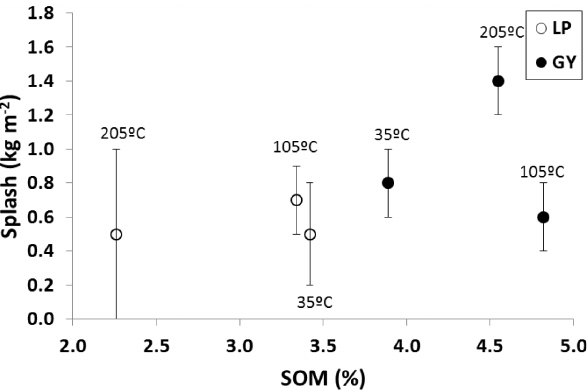
Fig. 6. Relationship between soil organic matter and splash erosion in both soils (means and standard